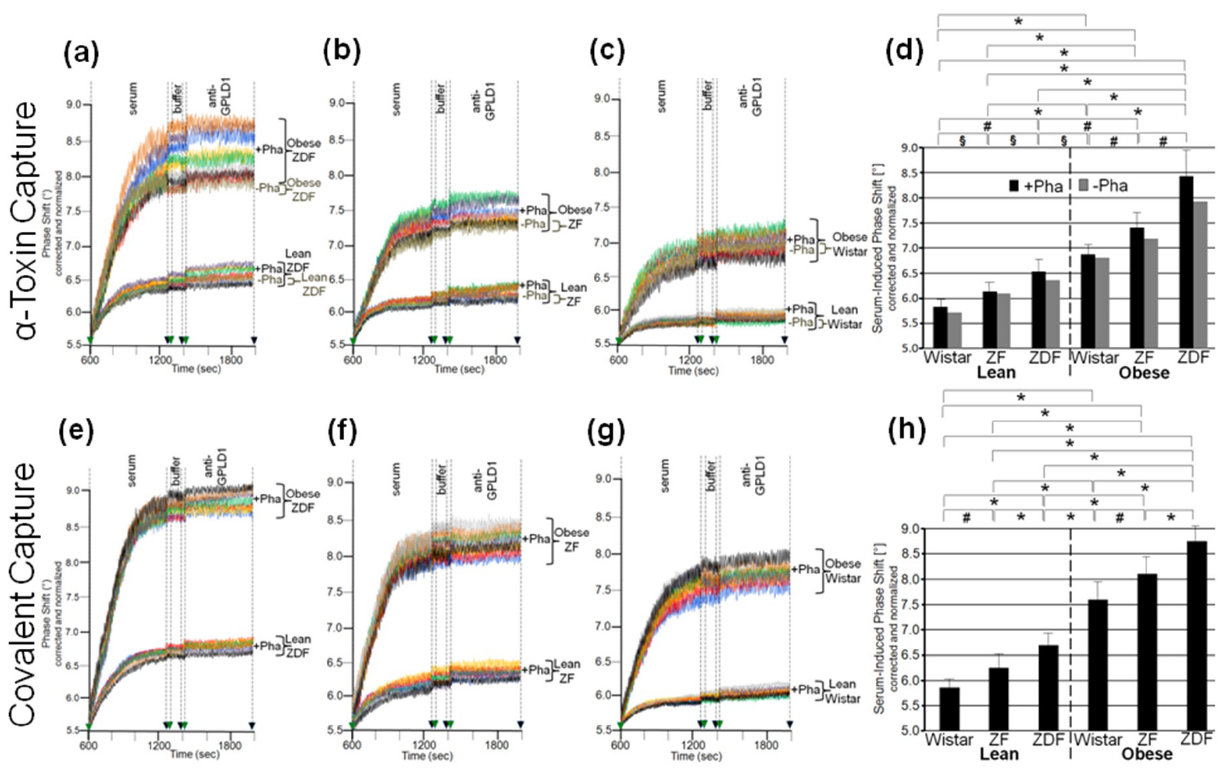
Figure 5. Measurement of the interaction of rat serum proteins not identical with GPLD1 with micelle-like bAChE complexes. ( a – c ) GPLD1-depleted sera were injected in the absence (dark brown curves only) or presence of Pha (0.5 mM, otherwise colored curves) into α -toxin-coated chips with captured micelle-like bAChE complexes. ( e – g ) GPLD1-depleted sera were injected in the presence of Pha (0.5 mM) into chips with covalently captured micelle-like bAChE complexes. After washing with buffer, anti-GPLD1 antibody was injected in the absence or presence of Pha in correspondence to the serum injection. ( a – c , e – g ) The experiment was performed and evaluated as described for Figure 4 with measurements shown only between 600 and 2000 s. The same chip was used for each rat group and the measurement repeated two times (different preparations of micelle-like bAChE complexes) with similar results (representatives shown). ( d , h ) The serum-induced phase shift (between 600 and 1300 s for serum injection and washing) determined in the presence of Pha ( n = 8; triplicate measurements, black bars, means ± SD) or absence of Pha ( n = 1; duplicate measurements, grey bars, shown only for α -toxin capture) is given. The comparison between the six rat groups is shown for the sera coinjected with Pha (black bars) only (* p ≤ 0.01, # p ≤ 0.02, § p ≤ 0.05).